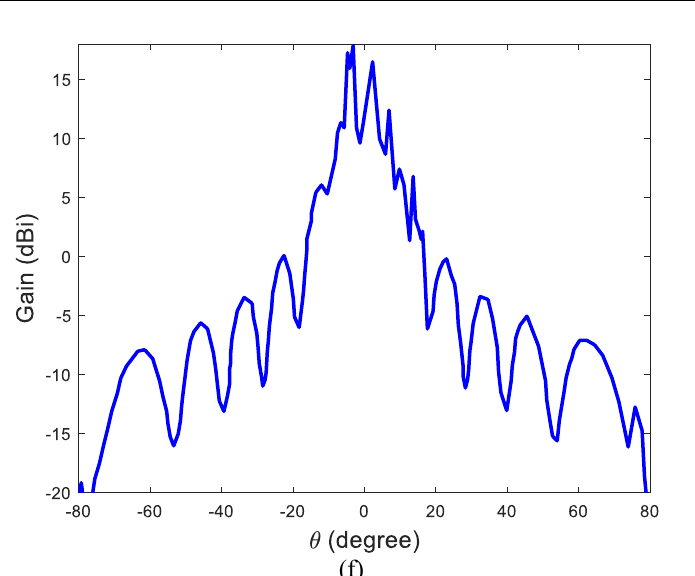
(f) FIGURE 10 [e, f ]. Radiation pattern of fault (s) and corresponding multivalued ANN output in the insets. (e) Radiation pattern for four elements ( 𝑚 ’. ,𝑚 ’,+& ,𝑚 -’ ,𝑚 .. ) faults (f) Radiation pattern for five element ( 𝑚 )( ,𝑚 ,. ,𝑚 (* ,𝑚 */ ,𝑚 +&,+& )